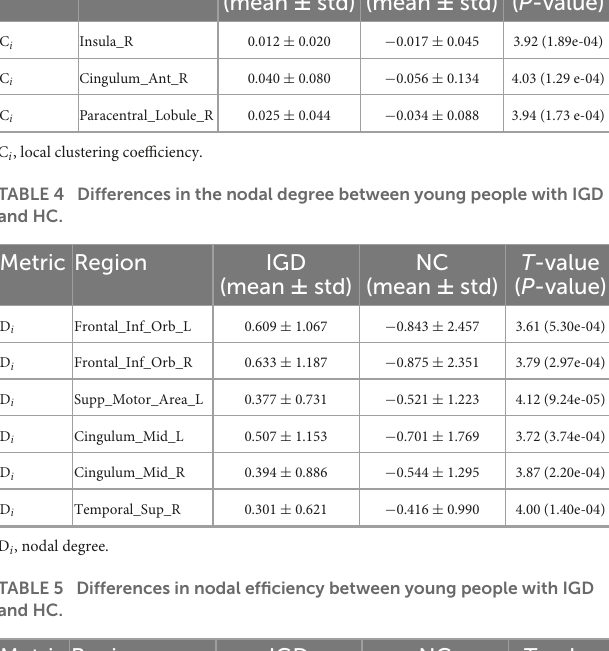
TABLE 3 Differences in local clustering coefficient between young people with IGD and HC. Metric Region